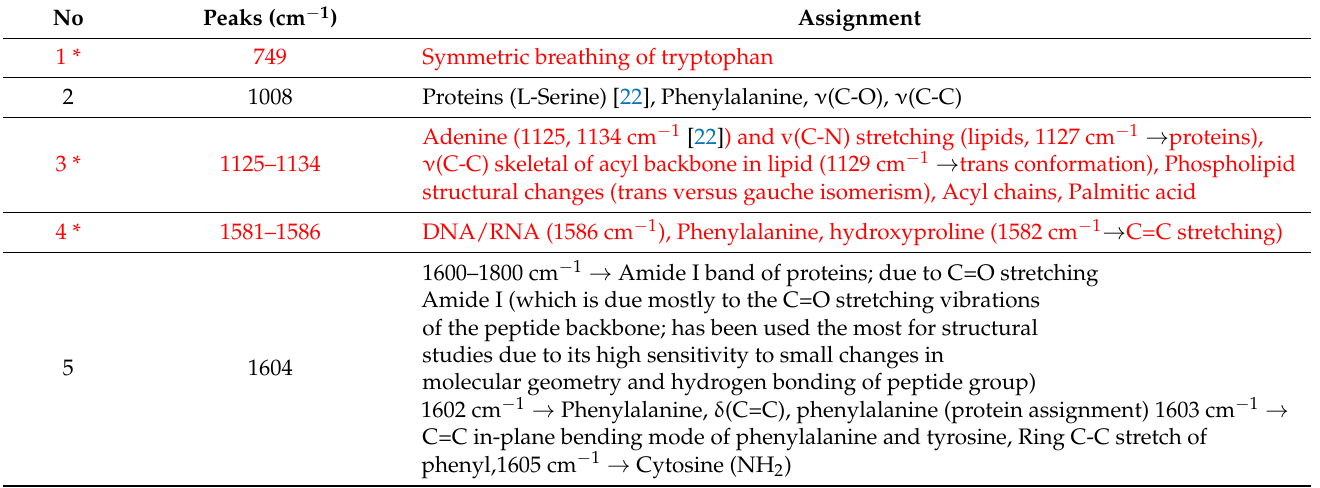
Table 5. Major Raman peaks found in BR3 under different temperatures. In red color and with an asterisk superscript the temperature dependent Raman peaks are presented.